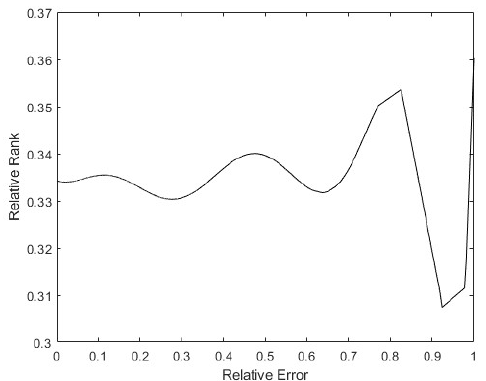
Figure 24. Polynomial regression of relative rank to relative error on X 4 .